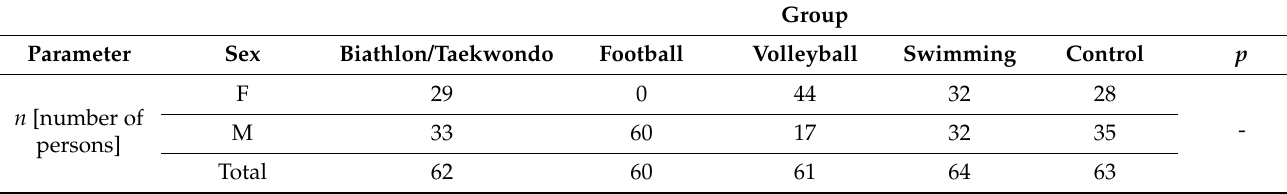
Table 1. Biometric data of the examined